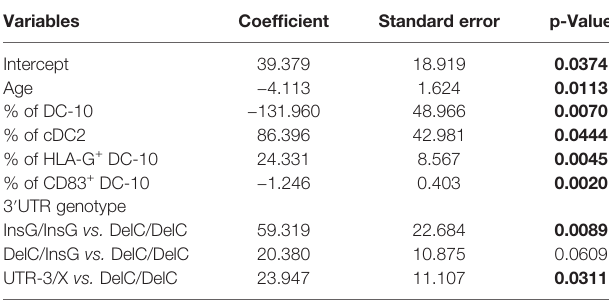
Final logistic mixed-effects model for predicting the type of group (individual at risk of develop T1D without autoimmunity, n = 37 Ab neg FDRs vs. n = 40 healthy controls), by accounting for the presence of several subjects within the same family. The fi nal model wasobtainedwithabackwardprocedureofvariableselectionasdescribedintheMaterial and Methods. Statistically signi fi cant p-values are indicated in bold. FDRs, fi rst-degree relatives; T1D, type 1